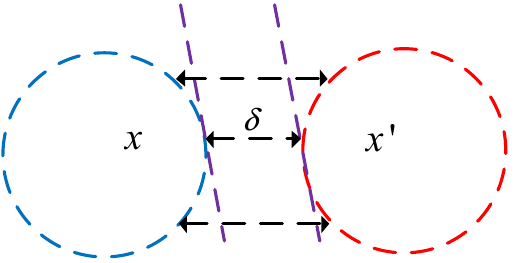
the original image x to fool the DNN. The relationship between the three parameters in Equation (4) is depicted in Figure 2.